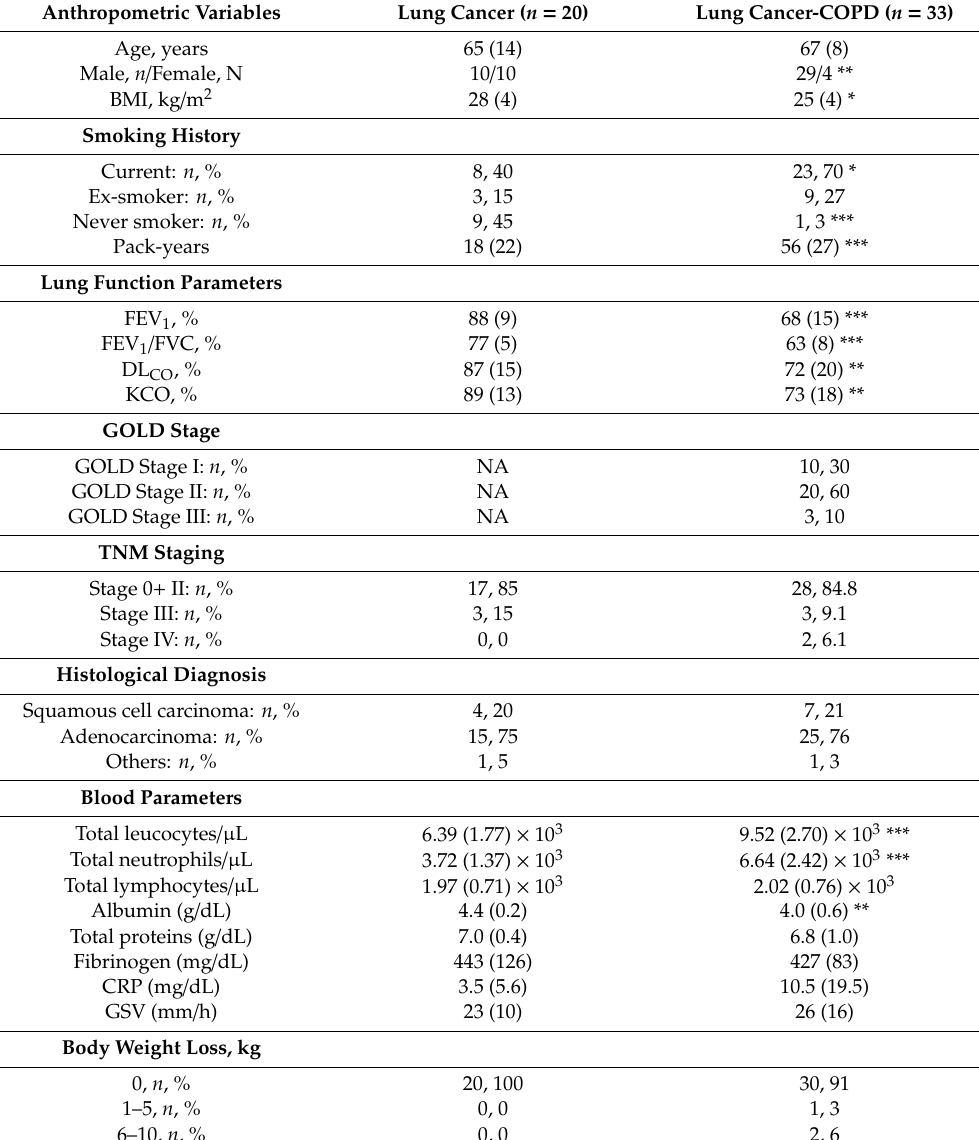
Table 1. Clinical and functional characteristics of the study